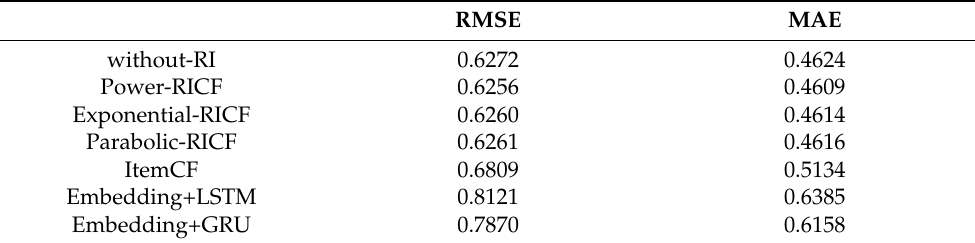
Table 3. RMSE of different comparative experiments on the MovieTweetings-latest dataset.